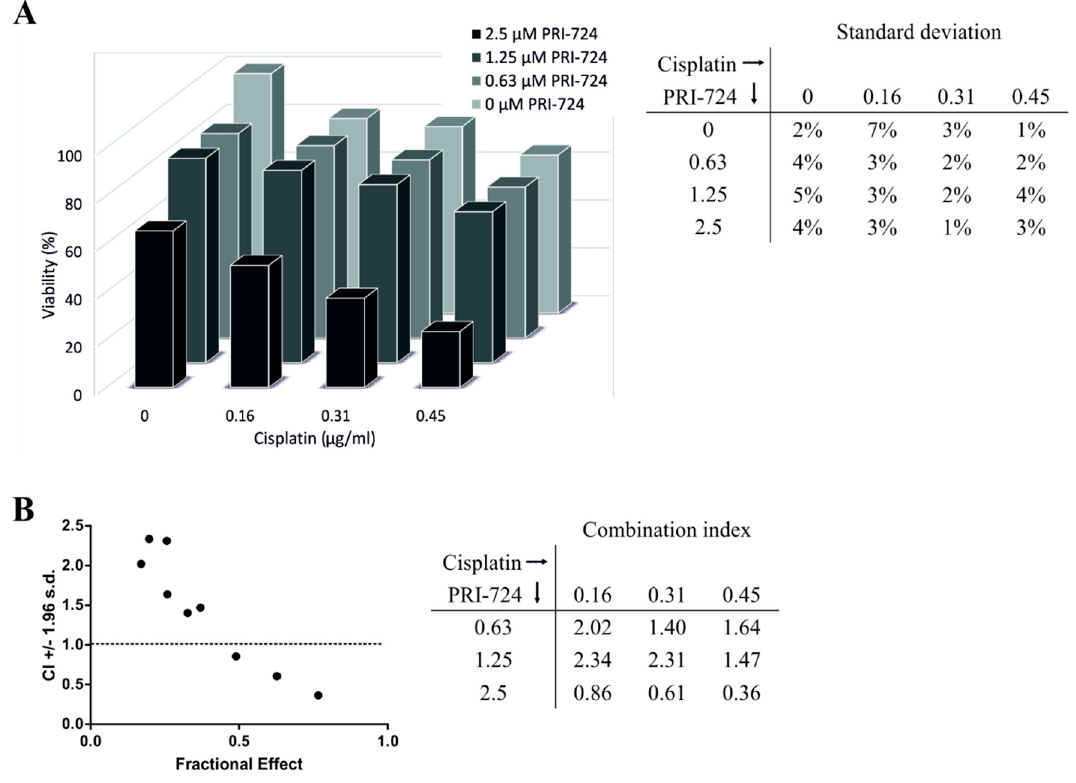
Figure 8. Cisplatin decreased viability of NTERA-2 CisR spheroids in combination with high concentration of PRI-724. ( A ) The effect of combined treatment with PRI-724 and cisplatin in NTERA-2 CisR multicellular spheroids. Relative viability was determined by luminescent viability assay on day 6. Values were expressed as the averages of hexaplicates and SD were indicated in the table. ( B ) Data obtained by luminometric assay were analyzed by Calcusyn software and Fa-CI plot was created. Plot displays synergism (CI < 1), additivity (CI = 1) or antagonism (CI > 1) for the entire spectrum of effects [36]. CI values were indicated in the table. CI—function of effect level, Fa—fraction affected (Fa = 1 − % of viable cells/100).